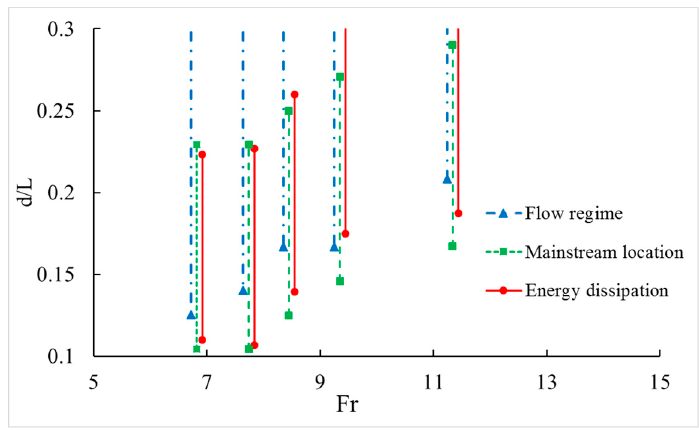
Figure 10. The range of the best depth of the stilling basin under three judgment conditions.